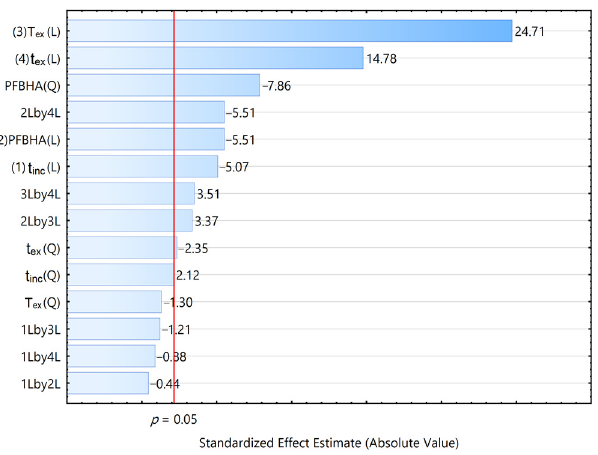
Figure 2. Pareto chart for the total area of all volatile carbonyl compounds of the GC–MS analysis of the HS-SPME of Huangjiu. the HS-SPME of Huangjiu .